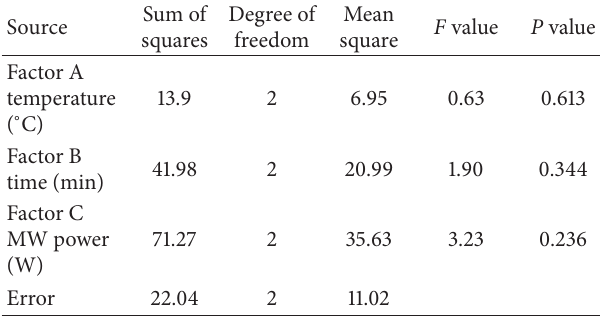
Table 5: Variance analysis of orthogonal experiment on synthesis of 𝛼 -acetylamino- 𝛽 -(3,4-diacetoxyphenyl)acrylic acid.